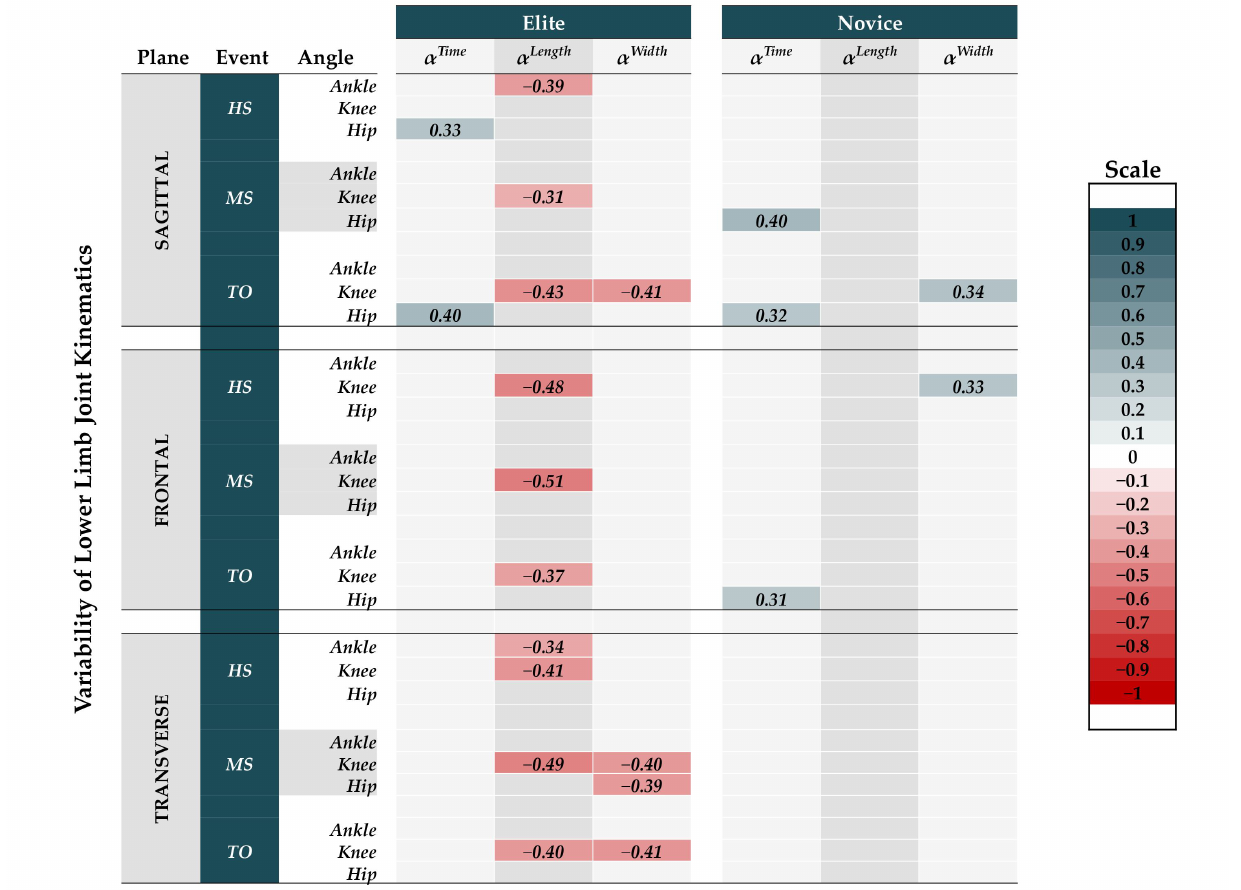
Figure 5. The results of the Pearson correlation analysis for the alpha exponent of spatiotemporal parameters with the variability of joint kinematics for elite and novice runners are presented above. In novice runners, the α Time had correlation only with hip SSV . At MS, the hip Flex-Exten angle had significant positive correlation with α Time . At TO, hip Flex-Exten and the hip